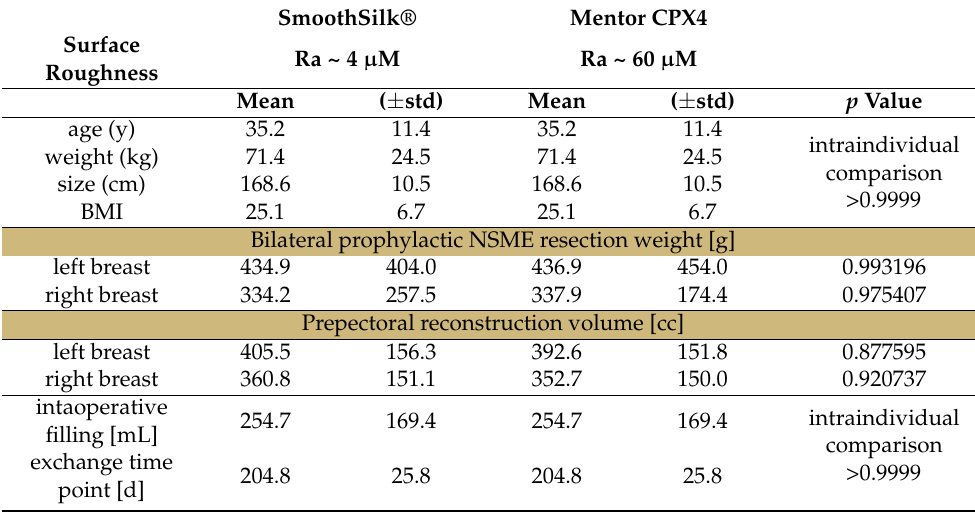
Table 4. Intra-individual statistical comparison of analytical